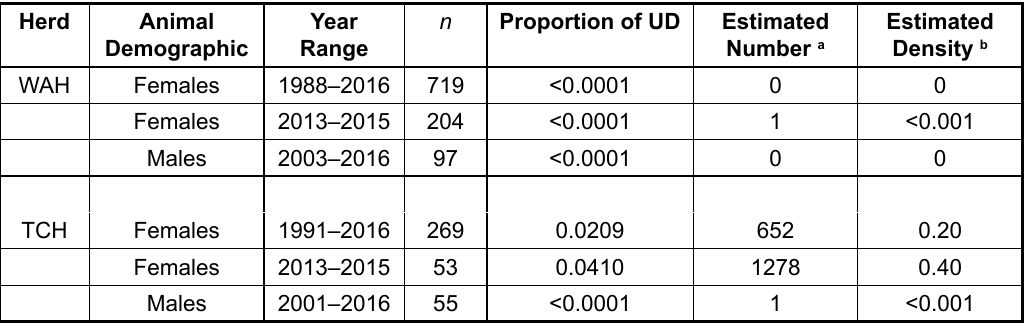
Table 2. Estimated number of caribou expected to be in the study area based on kernel density estimation of telem- etry data from the Western Arctic Herd (WAH) and the Teshekpuk Herd (TCH).